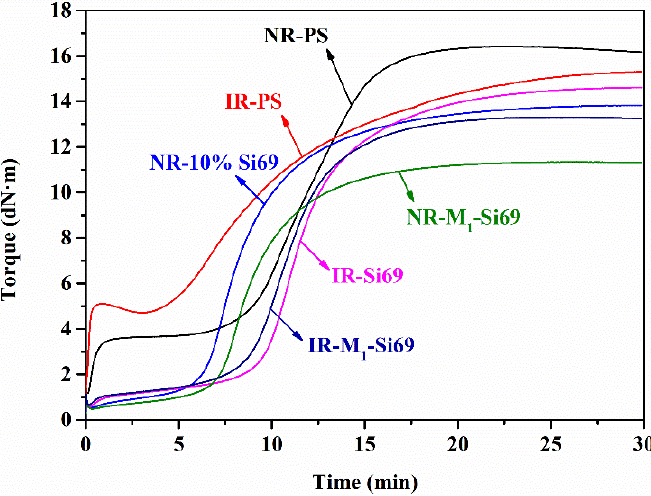
Figure 6. Vulcanization curves of NR and IR nanocomposites.